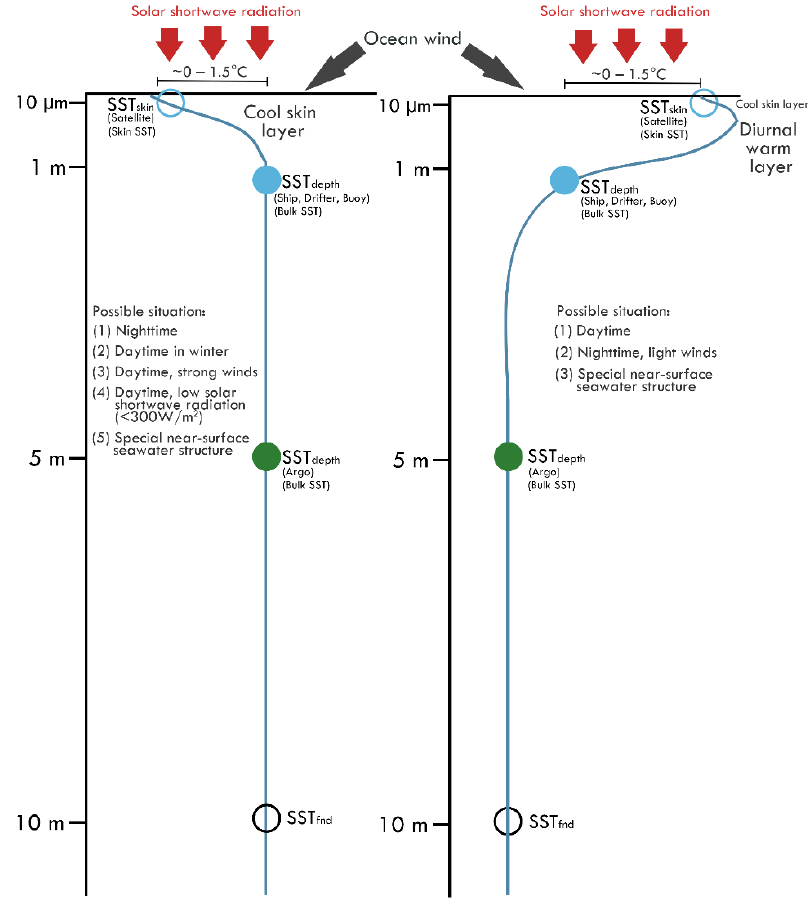
Figure 12. Schematic diagram of the ocean near-surface temperature